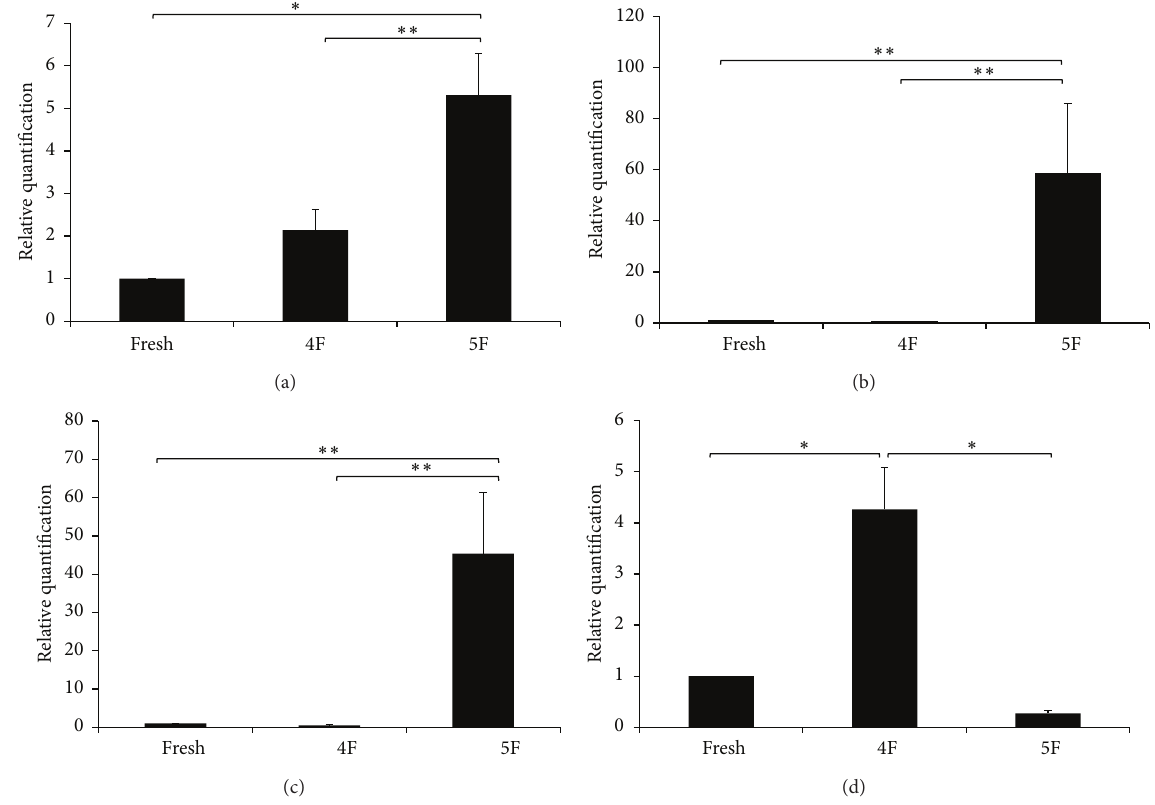
Figure 5: Pluripotency genes expression. Relative quantitation of (a) c-myc , (b) nanog , (c) oct3/4 , and (d) sox2 genes expression analyzed by real-time RT-PCR of expanded CB-CD34 + cells cultured in 4F and 5F in KSR compared with unexpanded cells (D0). The glyceraldehyde-3- phosphate dehydrogenase (GAPDH) was used as a house keeping gene control. Data shown are mean ± SD of three experiments. ∗ 𝑃 < 0.001 , ∗∗ 𝑃 < 0.02